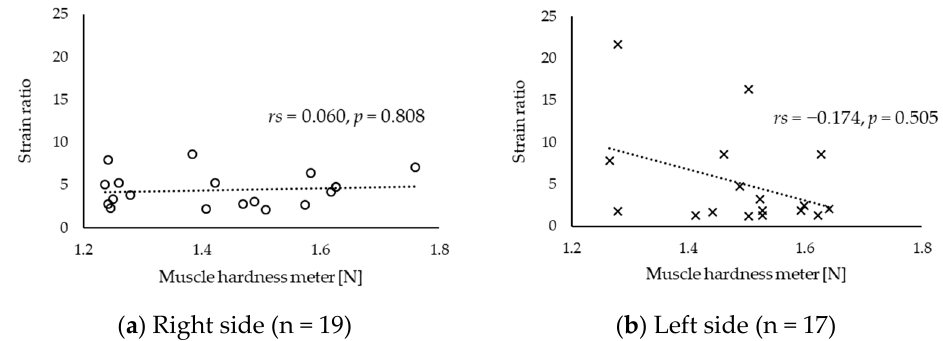
Figure 4. Scatter diagram between muscle hardness value assessed with a muscle hardness meter and that evaluated with strain ratio without outliers: ( a ) right side and ( b ) left side.